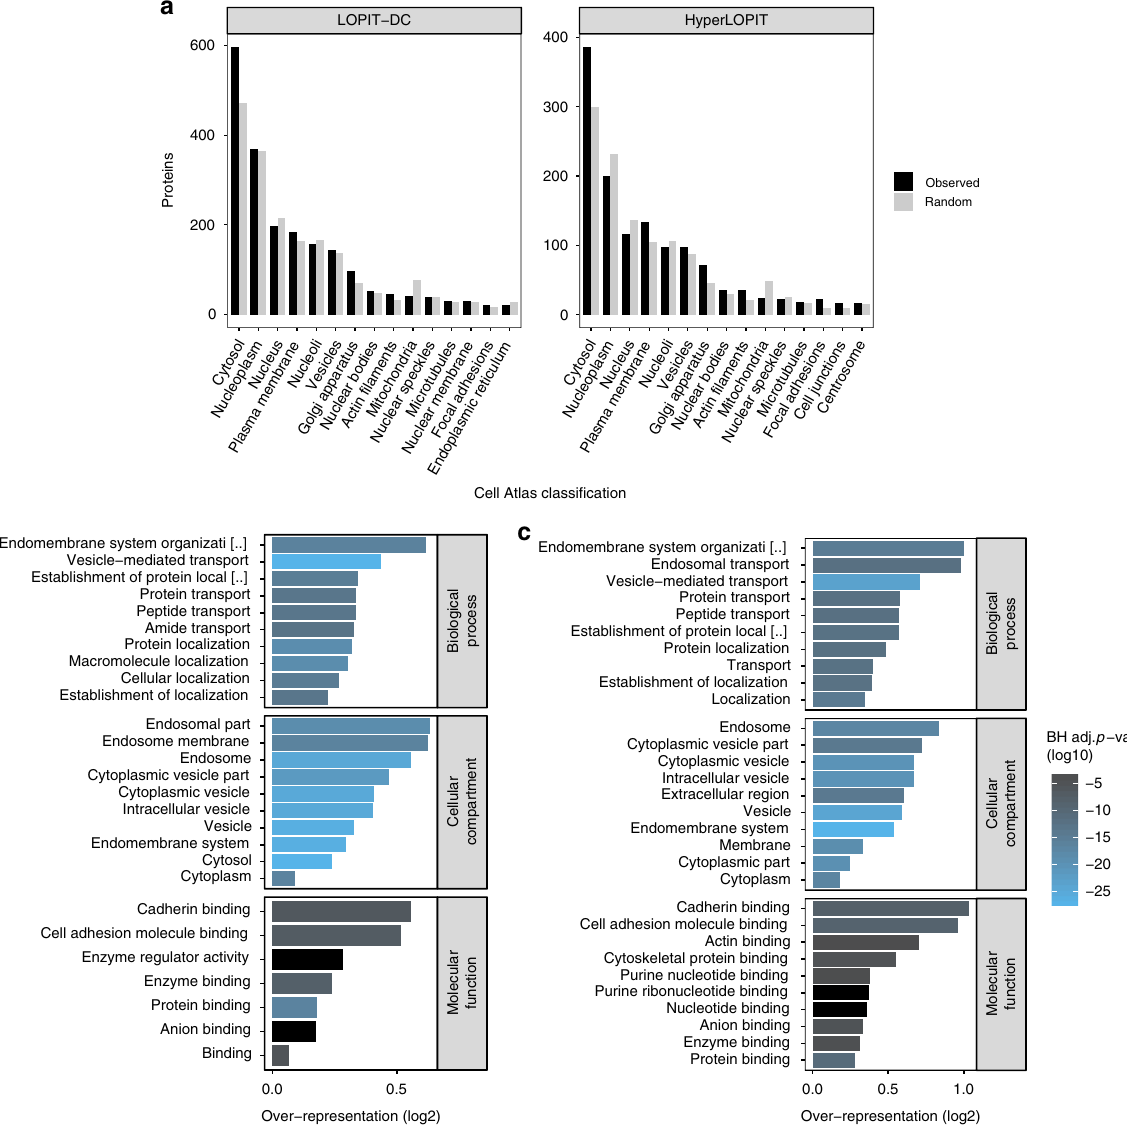
Fig. 6 The LOPIT unclassi fi ed proteome reveals proteins with multiple locations. a Cell Atlas database-derived subcellular location for proteins that remained unclassi fi ed in the LOPIT-DC and hyperLOPIT data. Grey bars represent the expectation from a random selection of the same number of proteins. Only the top 15 most frequent localisations are shown. b , c GO terms over-represented in the unclassi fi ed proteins for LOPIT-DC ( b ) and hyperLOPIT ( c ). Only the top 10 most over-represented terms per category are shown. BH adj. p -value = Benjamini-Hochberg 78 adjusted p -value for